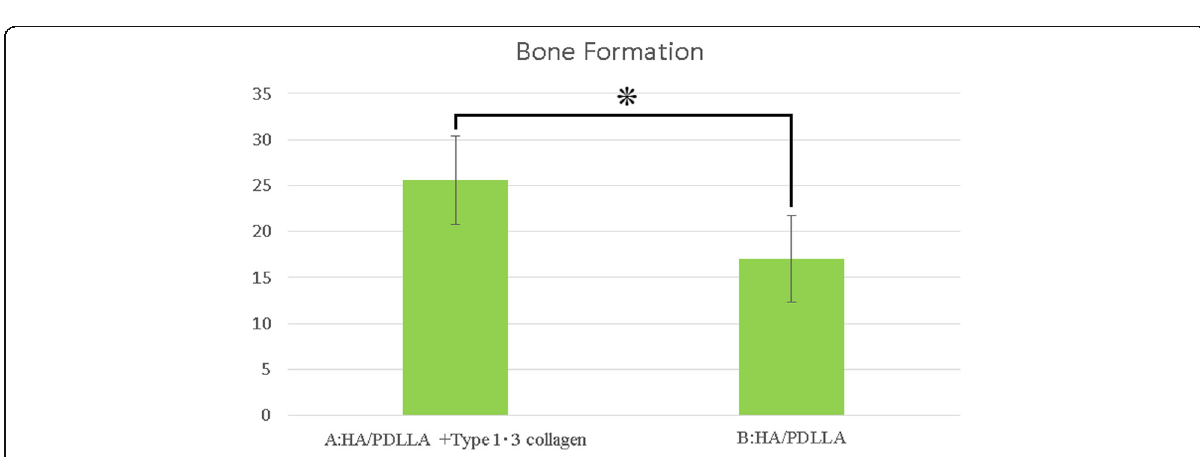
Fig. 5 Histomorphological assessment of the newly formed bone. Bone formation (%). The date represented mean±SD. * P <0.05. A:HA/PDLLA+type1 3 collagen B:HA/PDLLA. There is statistically significant difference